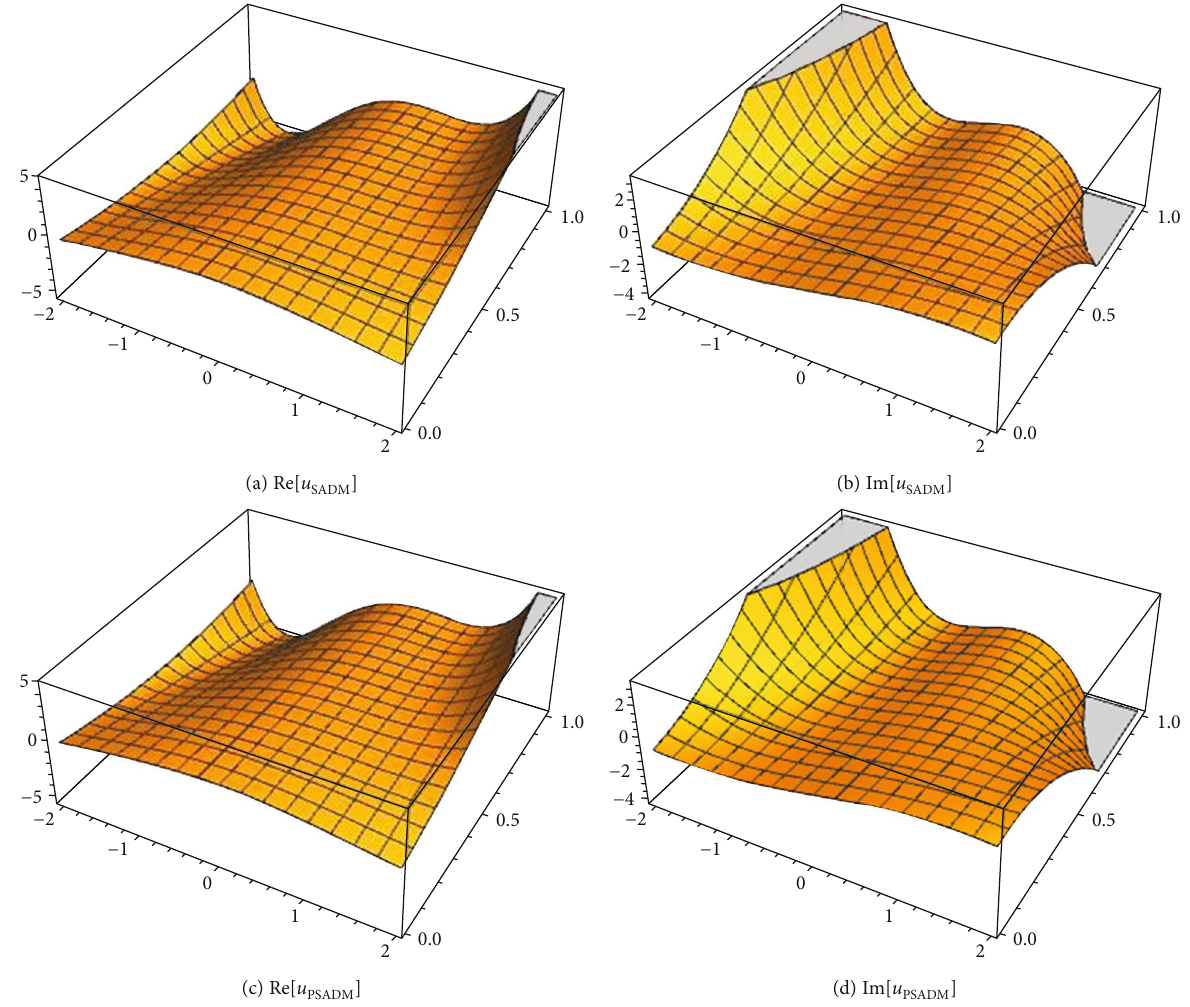
Figure 10: SADM and PSADM solutions using 3